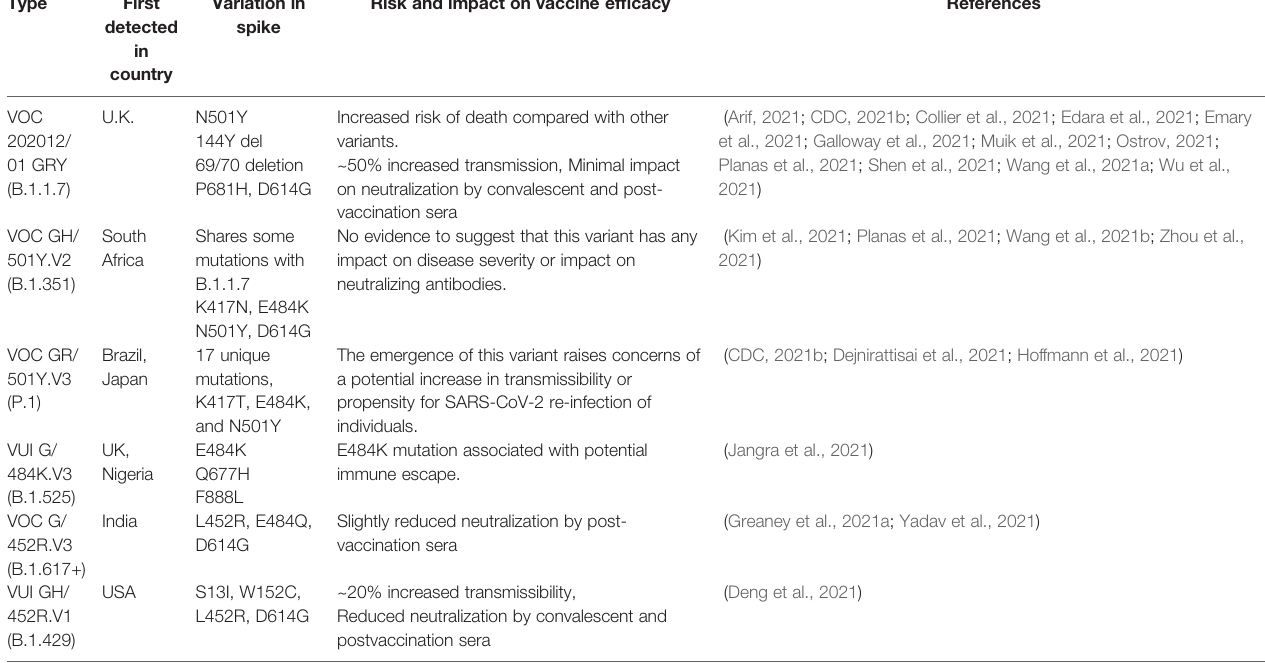
TABLE 3 | Major SARS-CoV-2